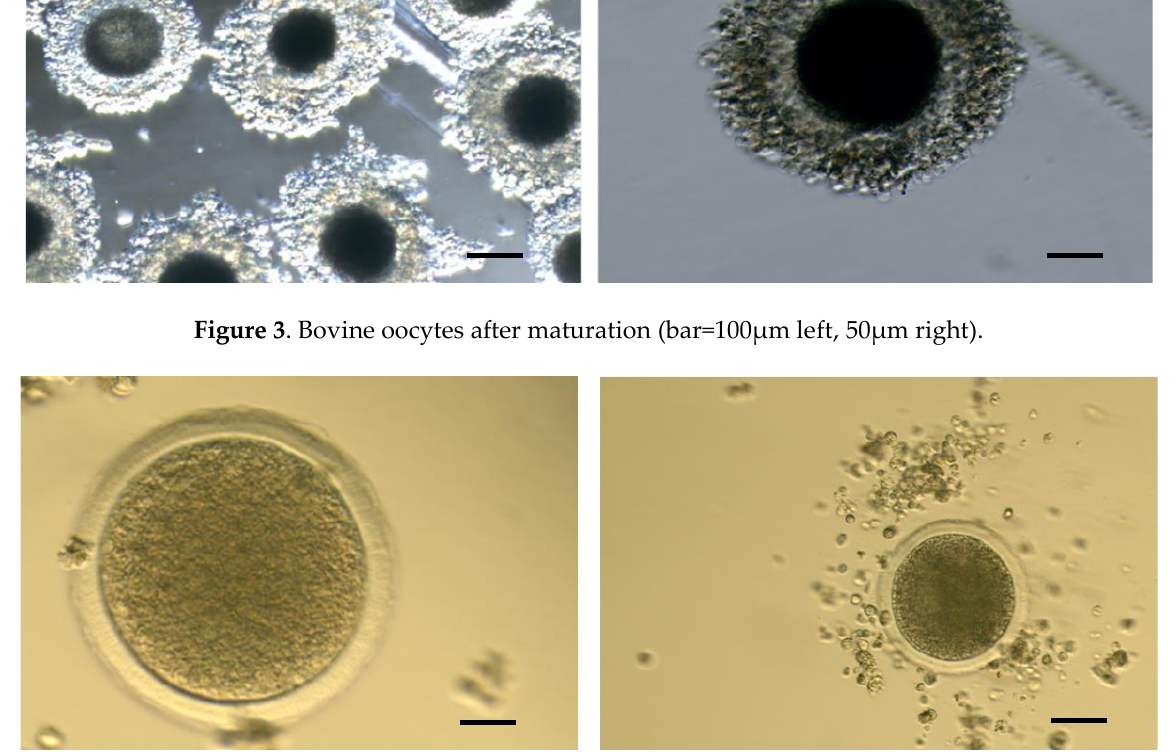
Figure 4 . Bovine oocytes after denudation (bar=30µm left, 50µm